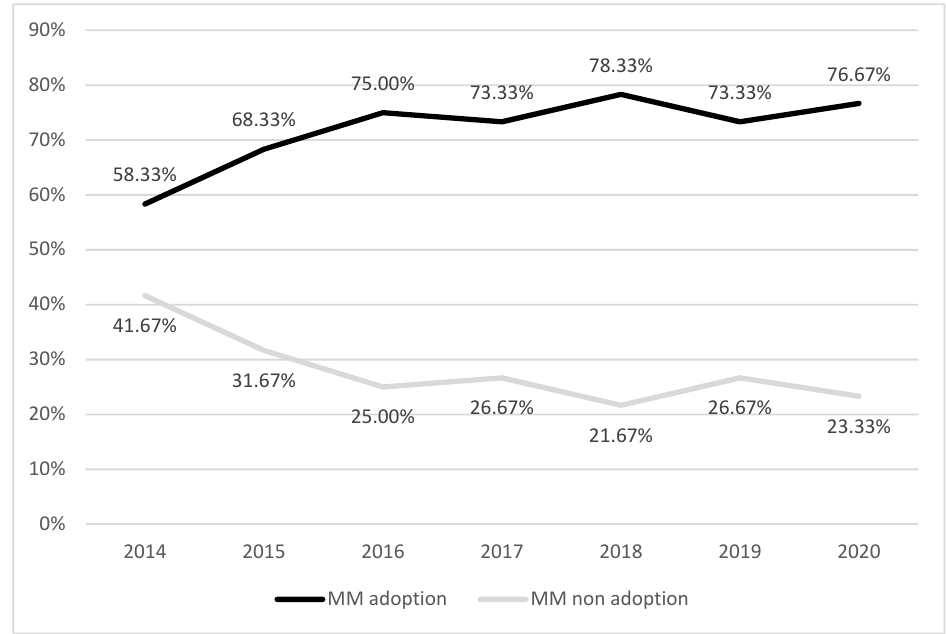
Figure 5. Materiality matrix adoption and non-adoption over time .